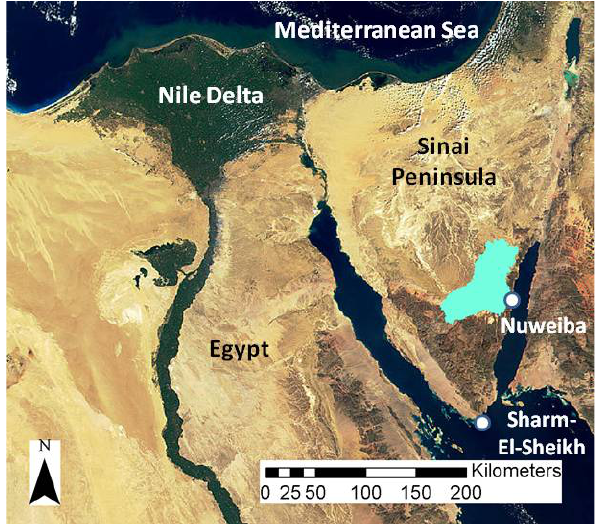
Fig. 1. Location of case study Wadi Watir in the Sinai peninsula of Egypt. Nuweiba is located at the outlet of Wadi Watir. The well- known tourist city Sharm El-Sheikh is located in the southernmost point of the Sinai